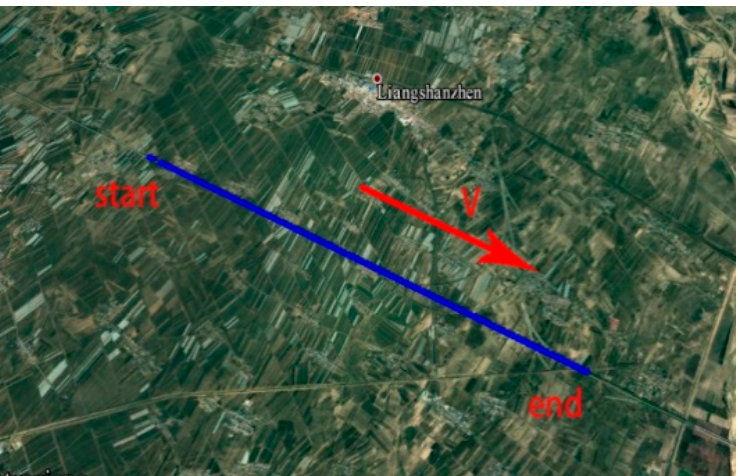
Figure 10. Test trajectory with disconnected GNSS signal.